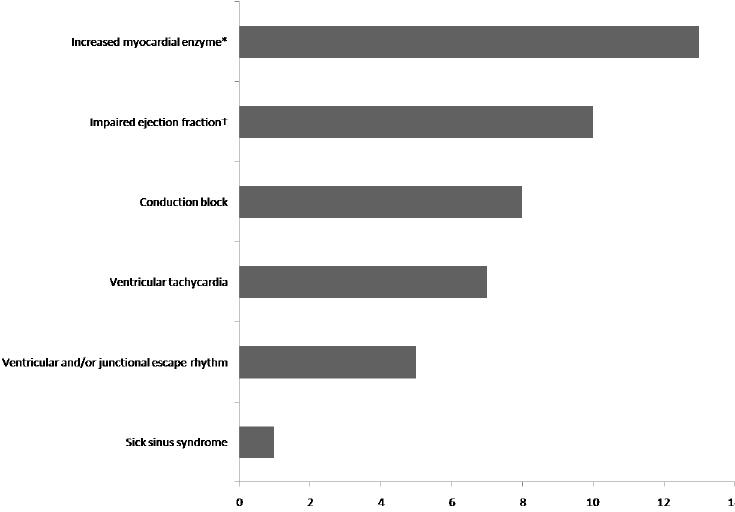
Fig 1. Cardiac dysfunctions in PBC patients. (cid:3) Performed in 19 patients, defined as CK > 198U/L, CKMB > 6.3ug/L or cTnI > 0.04ug/L. †defined as EF < 50%.